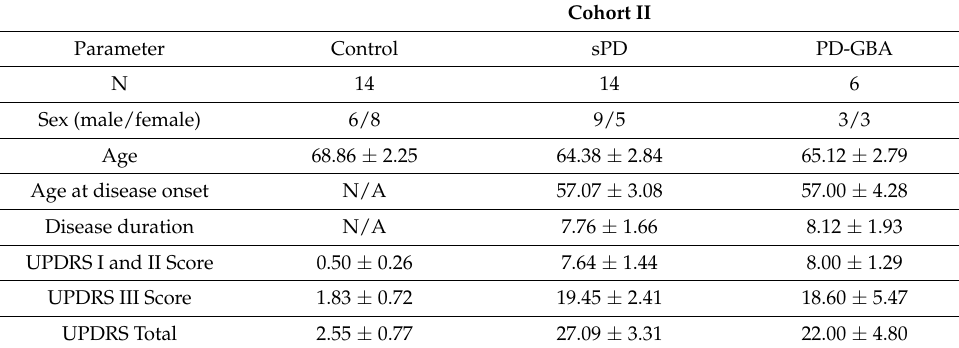
Table 2. Patient demographics and clinical assessment of sPD and PD-GBA patients in Cohort II. Data are mean ± SEM. GM1 in PBMCs were measured using our modified analytical method. UPDRS I and II were calculated for 12 healthy controls, 11 sPD, and four PD-GBA. UPDRS III and total UPDRS were calculated for 11 healthy controls, 11 sPD, and five